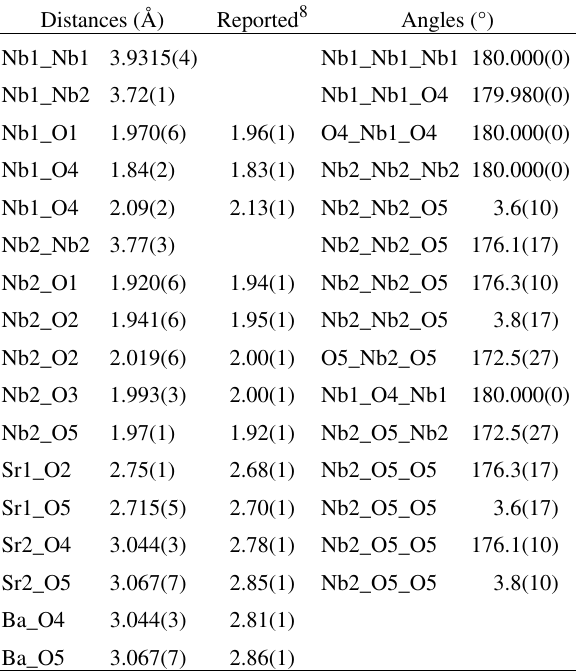
Table 4. Selected interatomic distances and angles. Other reported values are included for